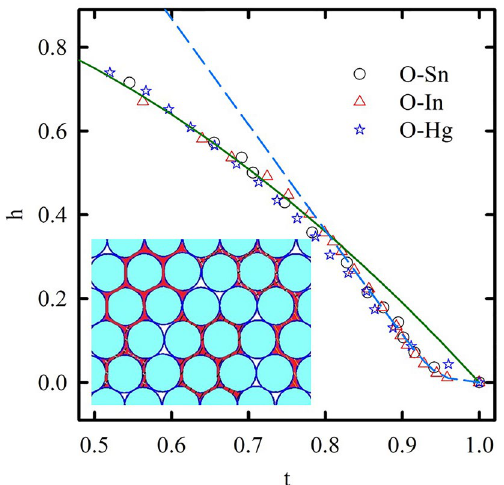
Figure 8. The normalized phase diagram of O-Sn, O-In, and O-Hg. The green solid line shows the fitting curve of two-fluid model. The blue dashed line represents the proximity effect model: 1 − t = α h + parameters: α = 0.394 , β = 0.058 , and (cid:31) = 19.48 . The inset presents a cartoon cross-section view of the opal nanocomposites. The blue balls show the opal template and the red color indicates metallic inclusions forming the dendritic grains. Different single crystalline grains are marked by different